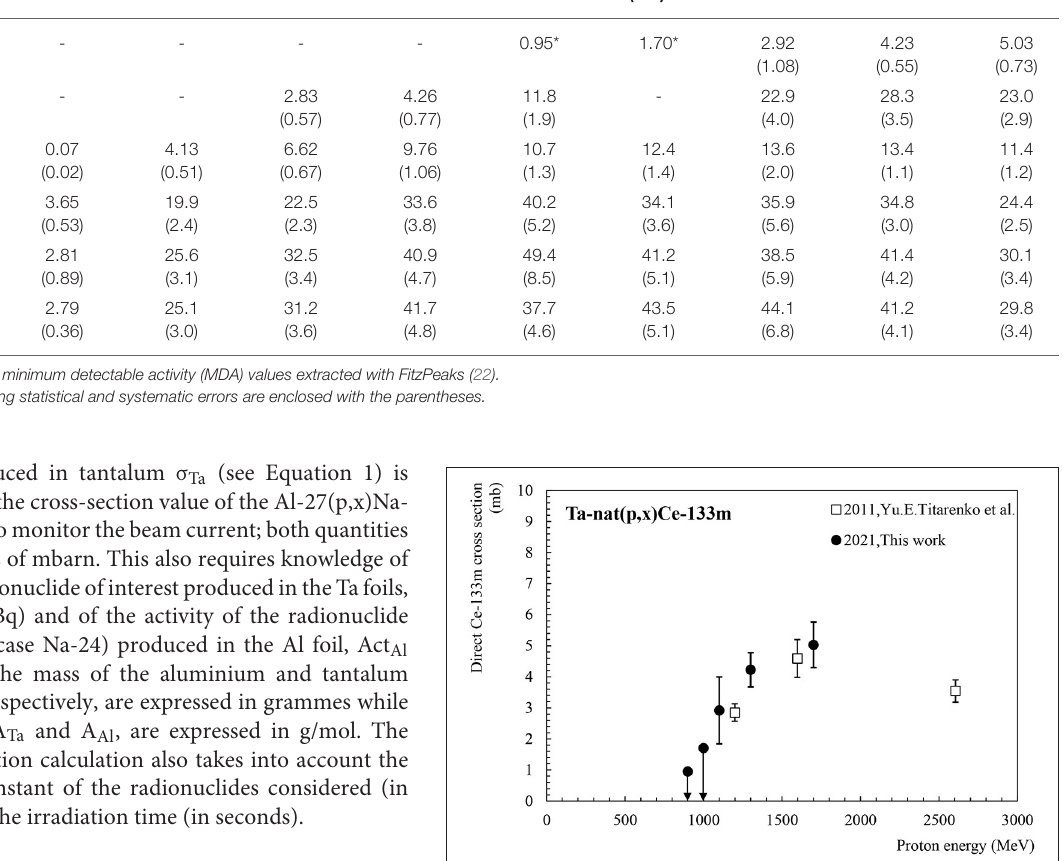
TABLE 2 | Production cross-section for Ce-133m, Ce-139, Tb-149, Tb-152, Tb-155 and Dy-155, for different proton-irradiation energies between 300 and 1,700 MeV. Energy 300 500 600 700 900 1,700 (MeV) Production cross-section (mb)